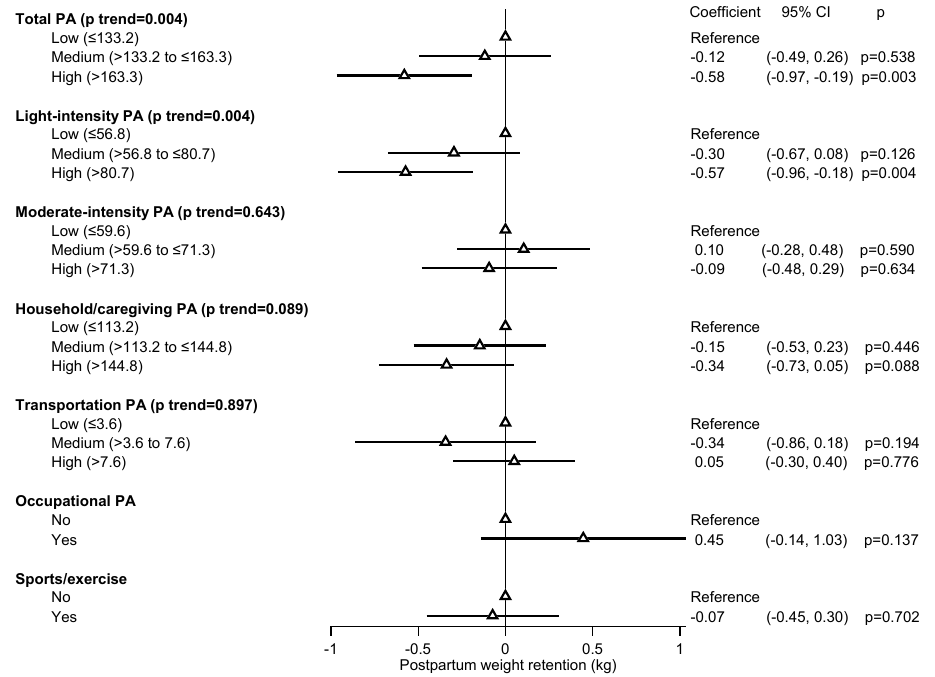
Figure 1. General linear model of one-year postpartum weight retention repeated measures in relation to physical activity at 3-month postpartum. GLM models for each physical activity intensity and domain were adjusted for maternal age at enrolment, education, formal employment, parity, pre-pregnancy BMI, mode of delivery, gestational age, gestational weight gain, total energy intake during pregnancy, and total physical activity during pregnancy; CI, confidence interval; MET, metabolic equivalent of task; PA, physical activity.